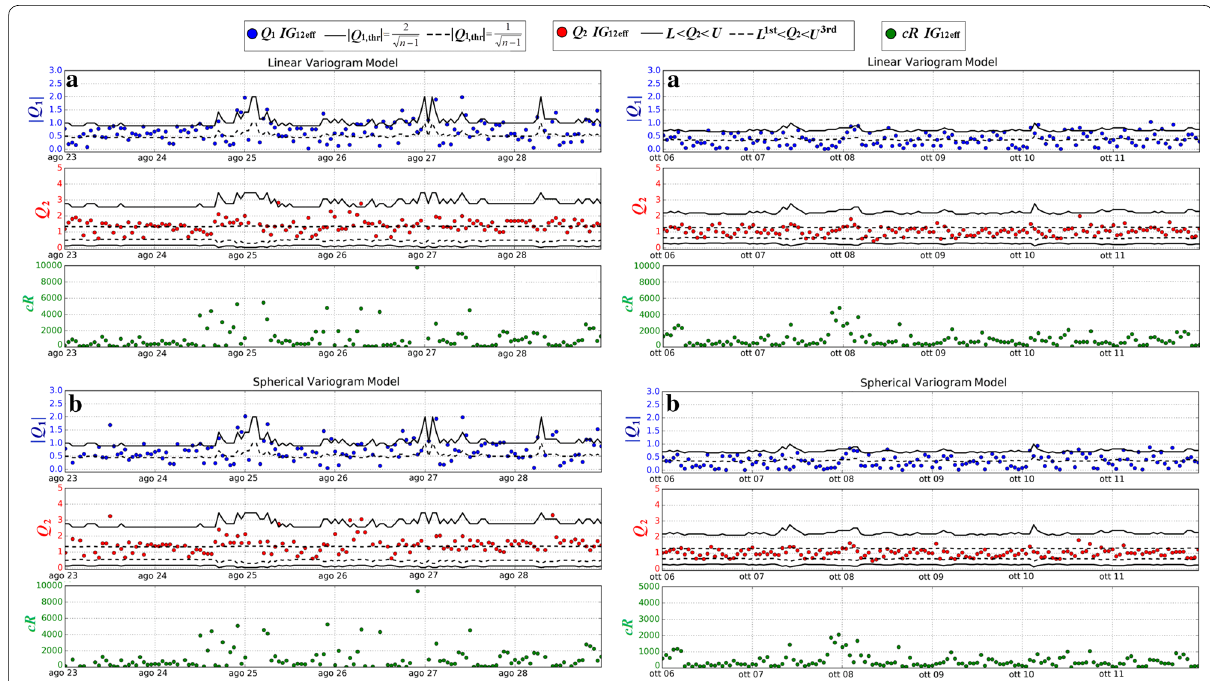
Fig. 8 Q 1 , Q 2 , and cR time series for IG 12eff , for selected storms and variogram models. Q 1 , Q 2 , and cR time series for a linear and b spherical variogram models for IG 12eff corresponding to the severe geomagnetic storms listed in Table 3 as number 12 (left) and 27 (right). The continuous and dashed black lines in Q 1 and Q 2 plots represent the threshold values as highlighted at the top of the figure